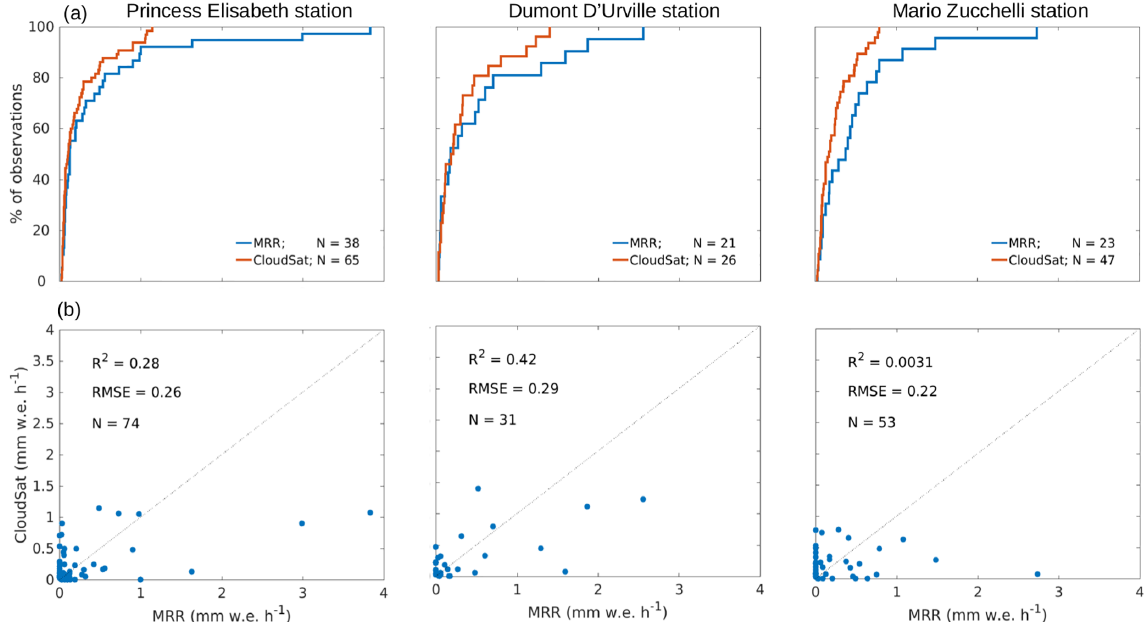
Figure 7. (a) Empirical cumulative distribution of MRR and CloudSat snowfall events at a spatial resolution of 1 ◦ latitude by 2 ◦ longitude. (b) Direct comparison between MRR and CloudSat individual snowfall events. R 2 denotes the adjusted coefficient of determination, RMSE is the root mean square error, N indicates the number of observations and the thin line is the